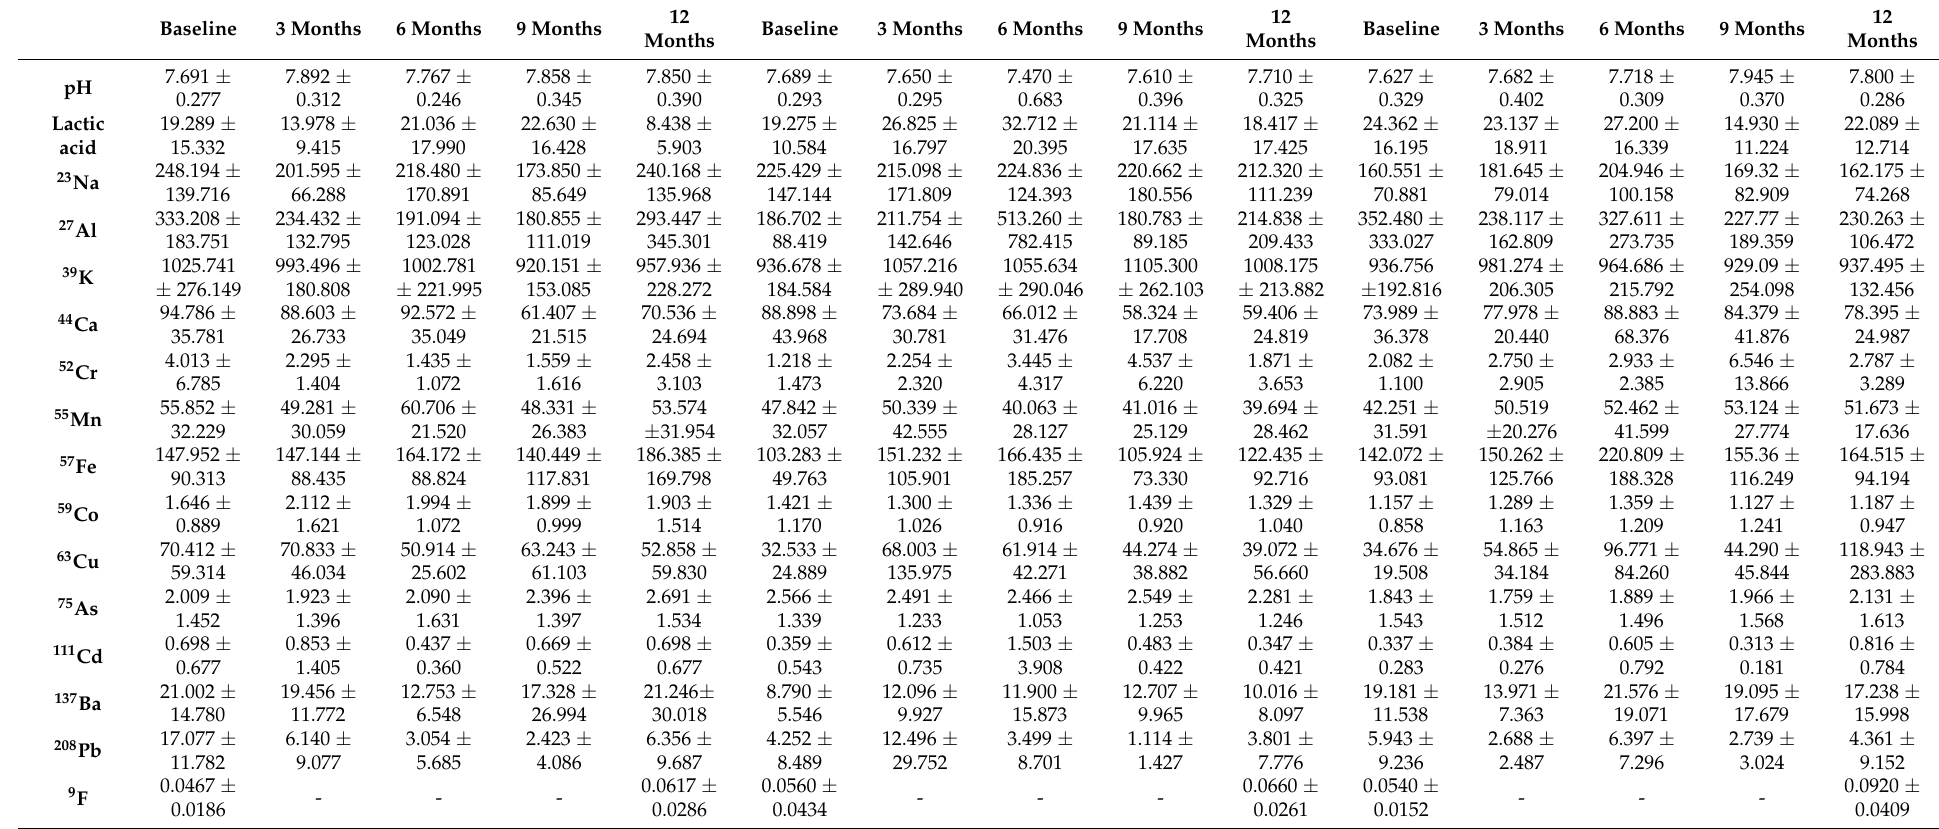
Table 5. Chemical elements with no significant